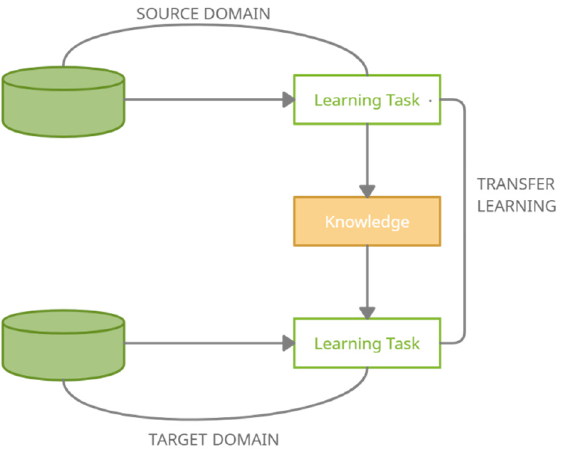
Figure 16. Transfer learning process.